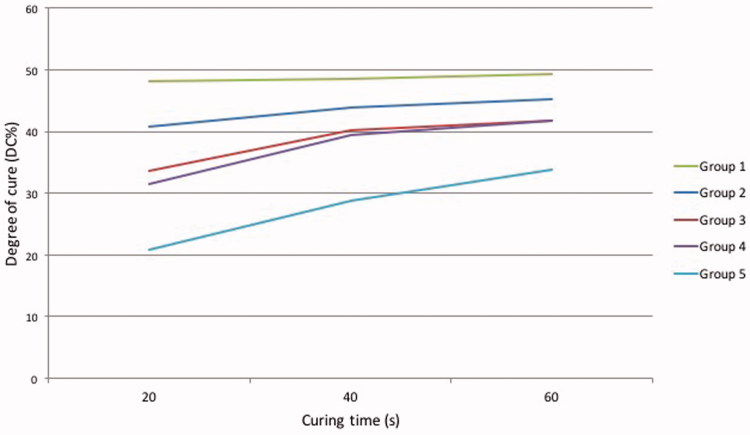
Mean degrees of monomer conversion (DC%) plotted against the curing time.